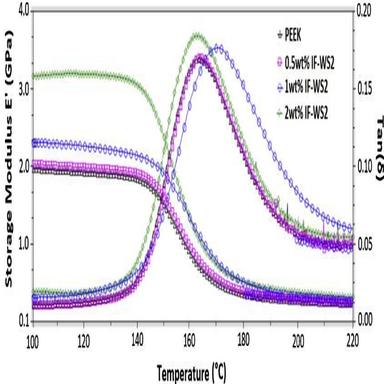
Storage modulus (E′) and Loss tangent (tanδ) vs temperature for injection moulded PEEK samples.